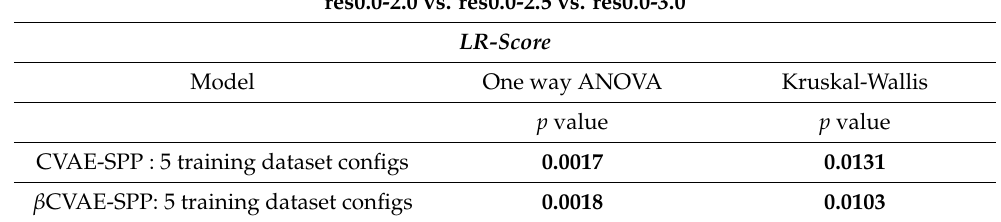
Table 2. Statistical significance test over 3 groups of EMD values (over LR-Scores of generated vs. training dataset distributions) corresponding to the three different input datasets. Each group includes EMD values over LR-Score distributions (generated versus training) obtained from a model trained over each of the five training dataset configurations. The test is repeated separately for CVAE-SPP and β CVAE-SPP. The non-parametric version of the One-way ANOVA test, the Kruskal Wallis test is included in the last column. p -values are shown. Those no higher than 0.005 are highlighted in bold, indicating that there are statistically-significant differences among the means of the three